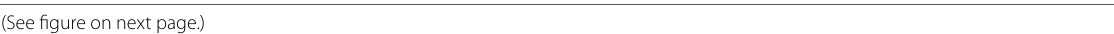
(See figure on next page.) Fig. 4 Undichna britannica , PIMUZ A/I 5060, equivalent of the Hangenberg sandstone, latest Devonian, El Khraouia, near Merzouga and Taouz. A Photo taken under shallowly angled white light with the main light source from the top right. B Drawing made from the photo in A with the main ichnofossils marked in colours ( Diplichnites —light blue, Rusophycus light green). Those belonging to U. britannica are marked in dark orange (main trace), red, and light orange (two somewhat discontinuous secondary traces) while more doubtful parts running subparallel are marked in yellow. The dark orange part was likely produced by the caudal